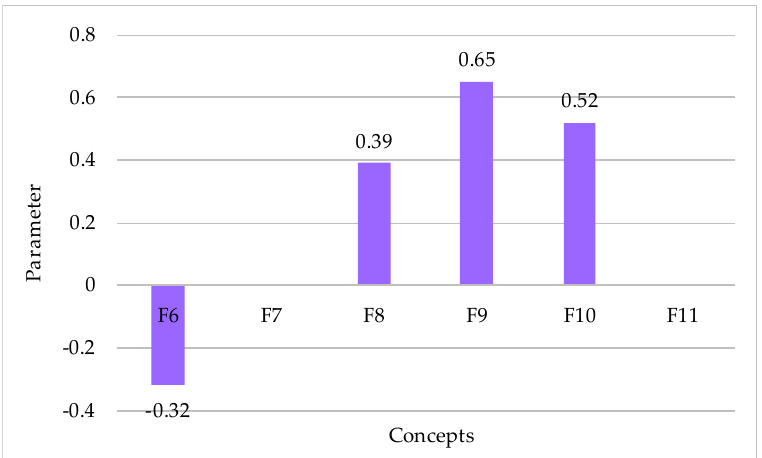
Figure 5. Scenario demonstrating the system response, with a complex maximum weakening of the impact of the most important